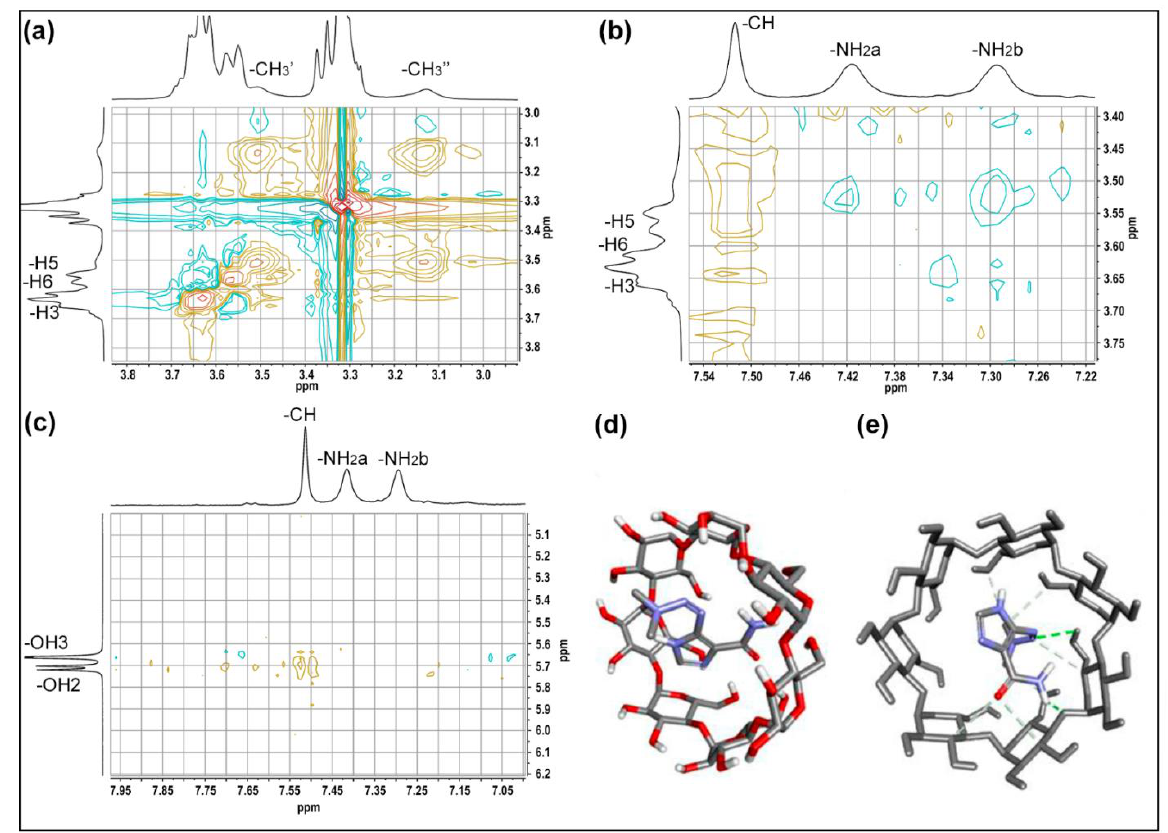
Figure 3. Amplification of the ROESY βCD@DB spectrum showing the interactions of the internal protons of βCD with: ( a ) protons from the -CH 3 groups of DB; ( b ) proton from the -CH group of the imidazole ring of DB; docking molecular of ( c ) favorable structure of inclusion; and ( d,e ) interactions of the protons of DB with the inner protons of βCD.